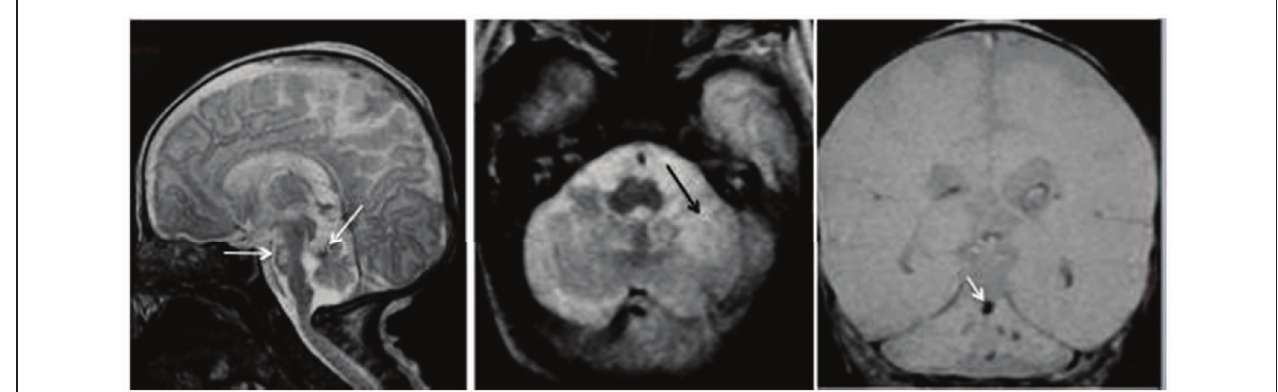
corresponding to hypoxic ischemic necrosis. Middle panel: the axial T2-WI shows the ischemic necrosis of the left cerebellar hemisphere (arrow) appearing bright. Right panel: the coronal T2 gradient-echo image shows multifocal dark signals in the vermis (arrow) and the left cerebellar hemisphere corresponding to hemorrhagic